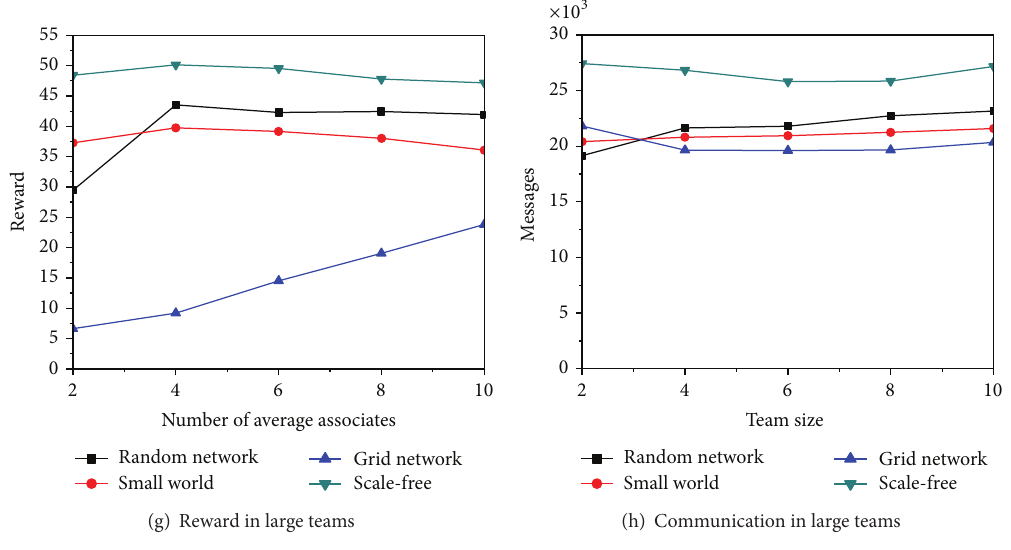
Figure 9: Effects of complex networks on different numbers of average associates.